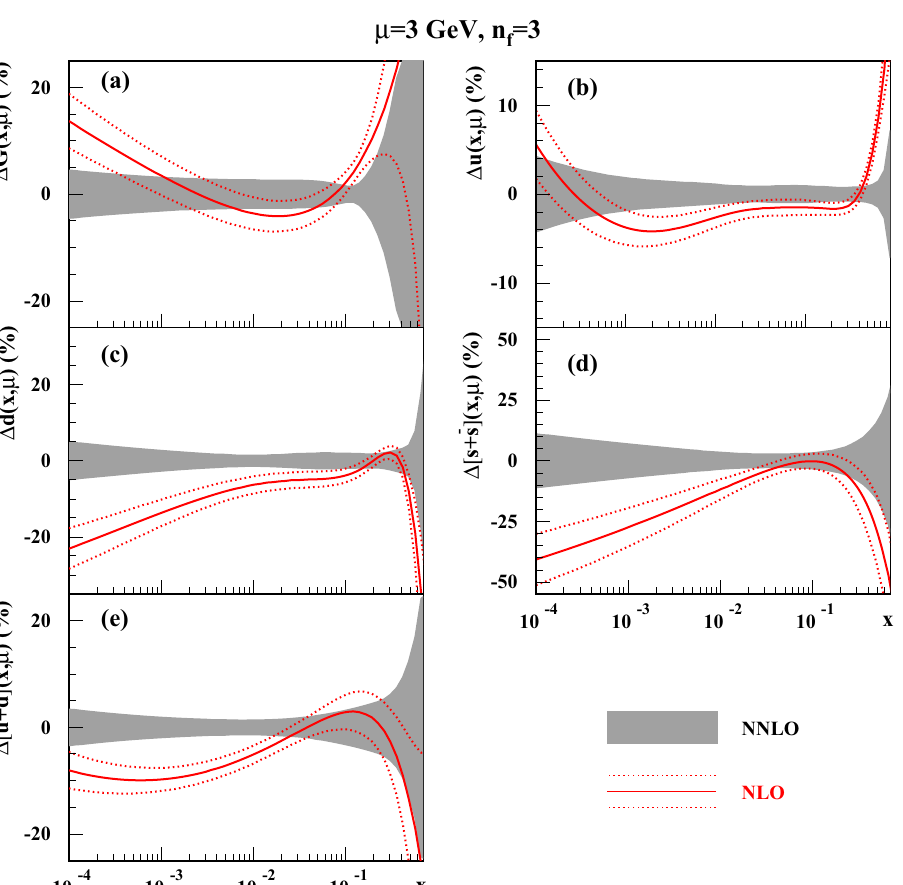
area) compared with the relative difference of those PDFs to the NLO ABMP16 ones obtained in the present analysis (solid lines). The dotted lines display 1 σ band for the NLO